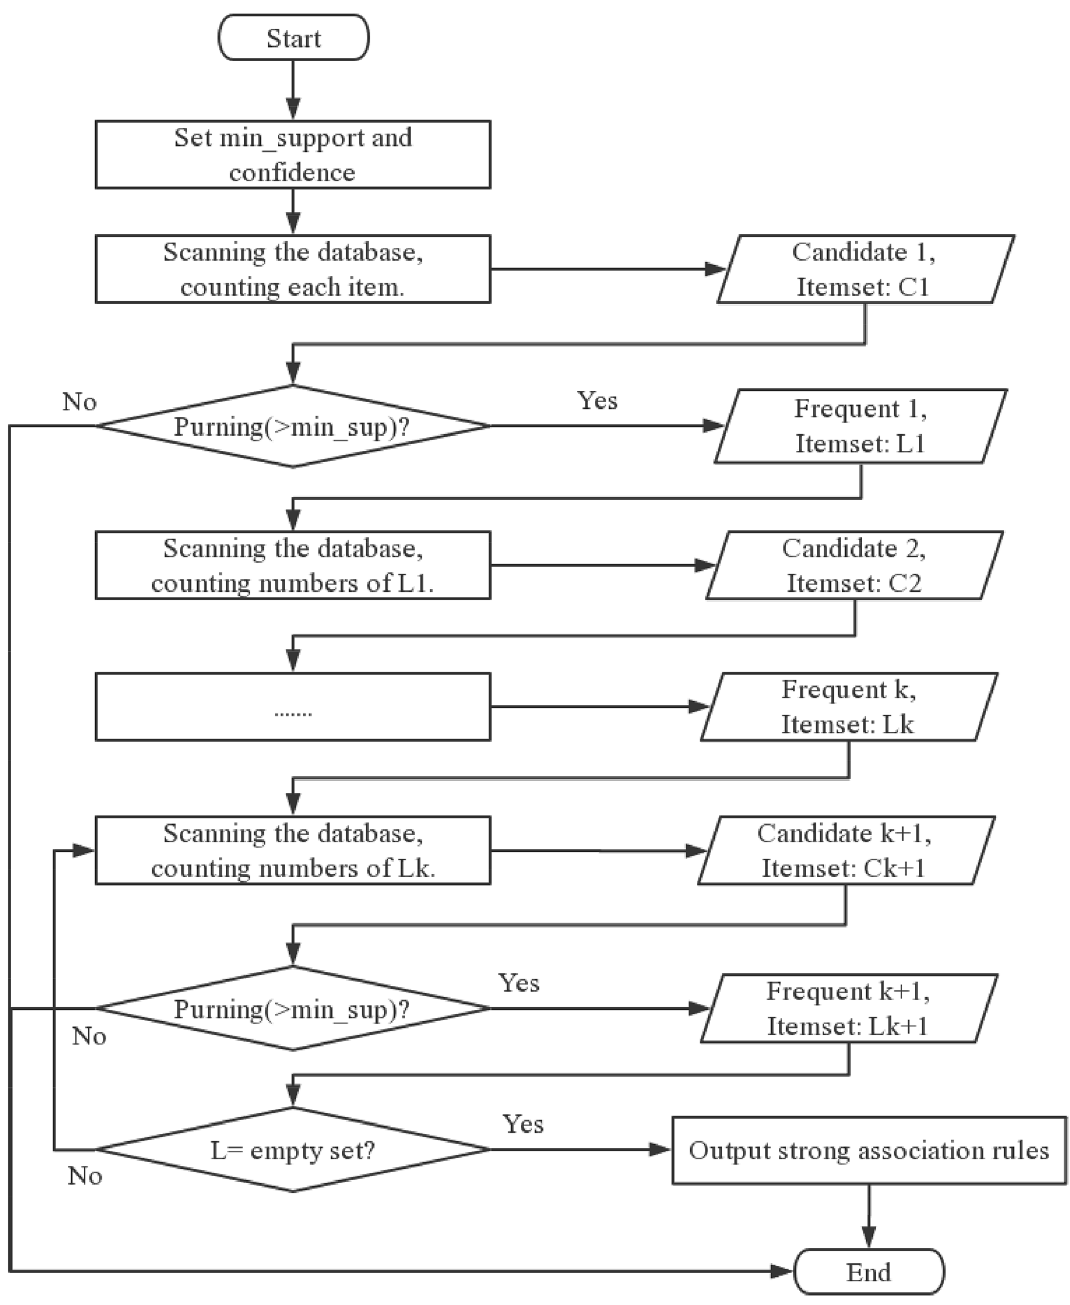
Figure 4. Flowchart of apriori computer